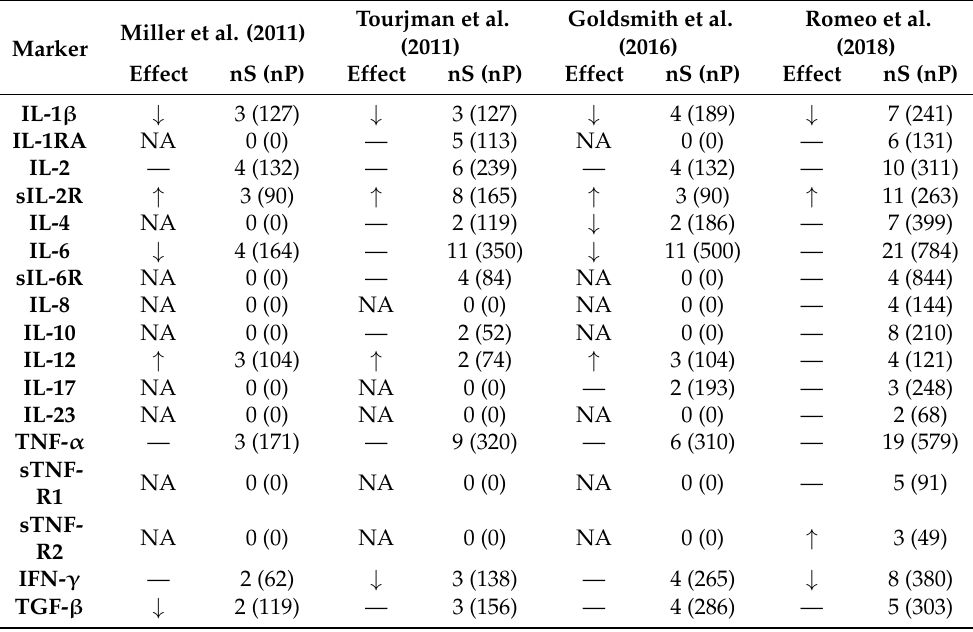
Table 4. Meta-analytical data concerning the effects of antipsychotics on peripheral cytokine levels without stratification by specific treatment or population.